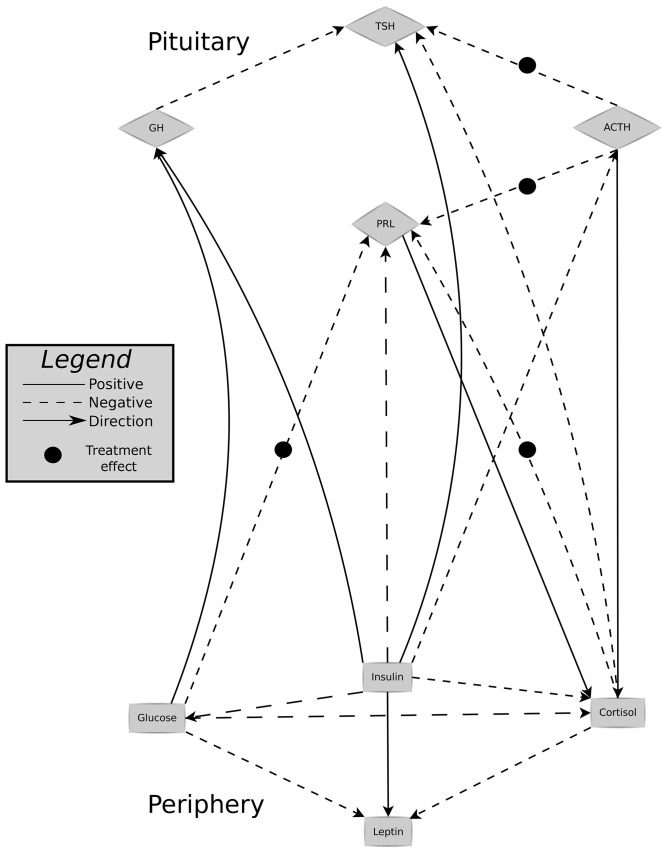
The dynamic hormone network and the treatment effect.Links with an arrow indicate directionality, links without are suppressed. The black circles indicate a significant treatment effect. The top four hormones are release in the pituitary, while the others are released in the periphery, and glucose is ingested as food.